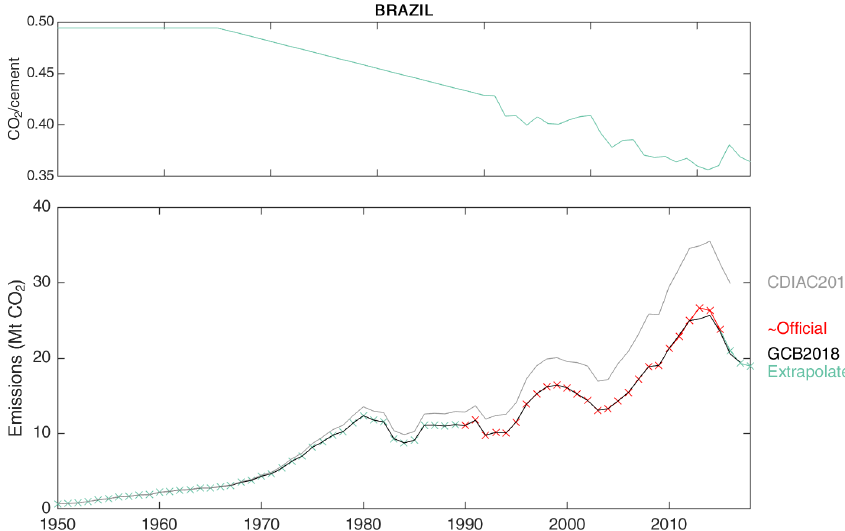
Figure C15. Revised cement emissions for Brazil.